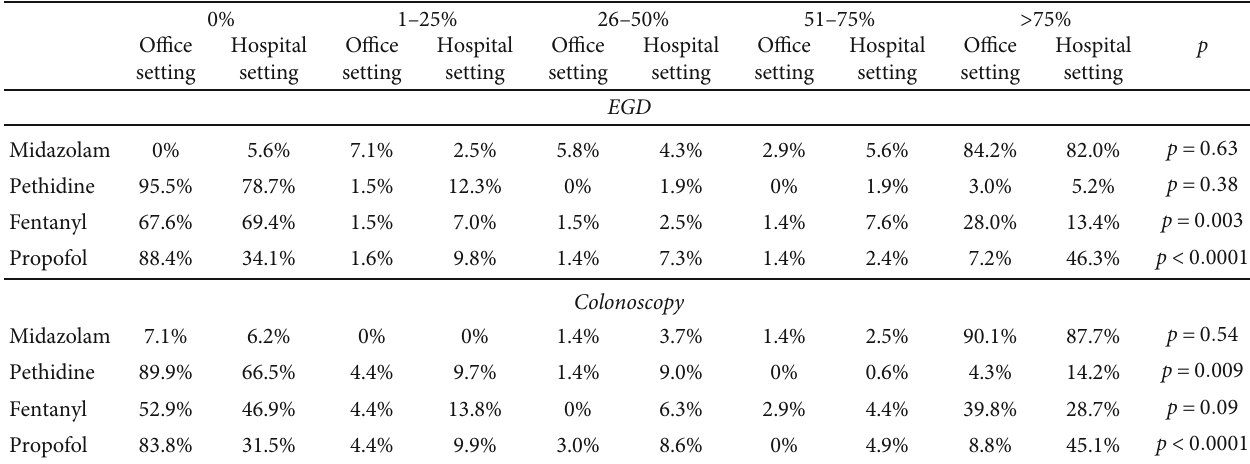
Table 2: Comparison of sedative/analgesic agents ’ use between private o ffi ce and hospital-based (private and public) settings. 0%